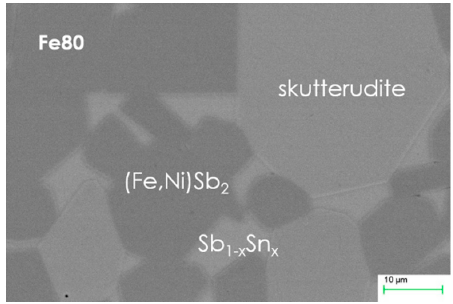
Figure 7. SEM microphotograph taken by secondary electrons on the polished surface of sample Fe80.